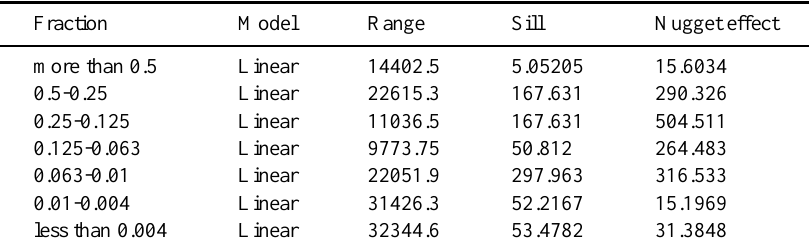
Table 1. Types of semivariogram models of all fractions and the parameters: range, sill and nugget effect.